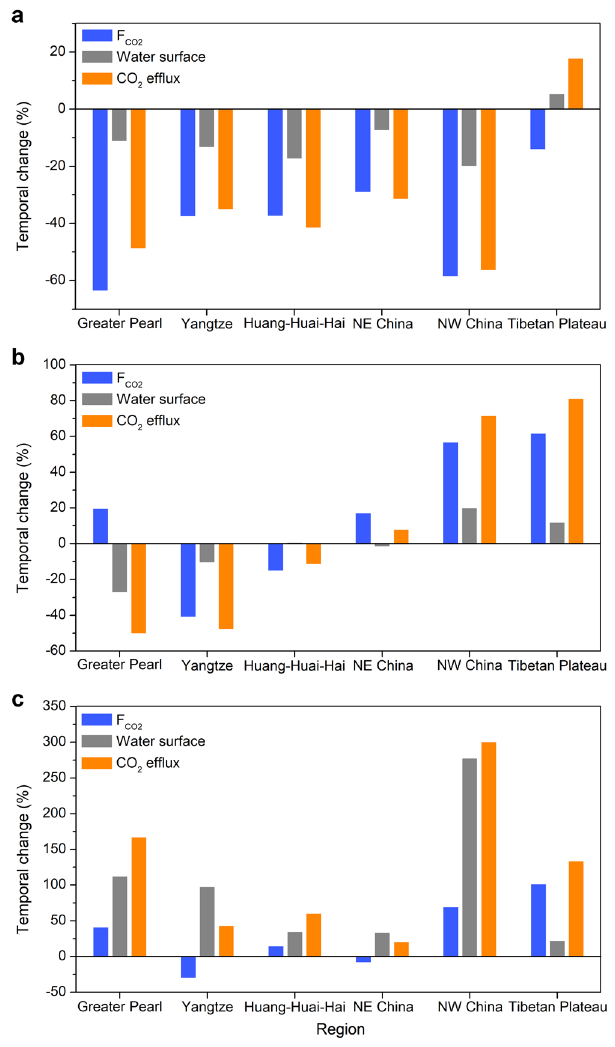
Fig. 4 Changes in F CO2 and water surface area drive the temporal pattern of the total CO 2 ef fl ux across the six regions in China. a Rivers. b Lakes. c